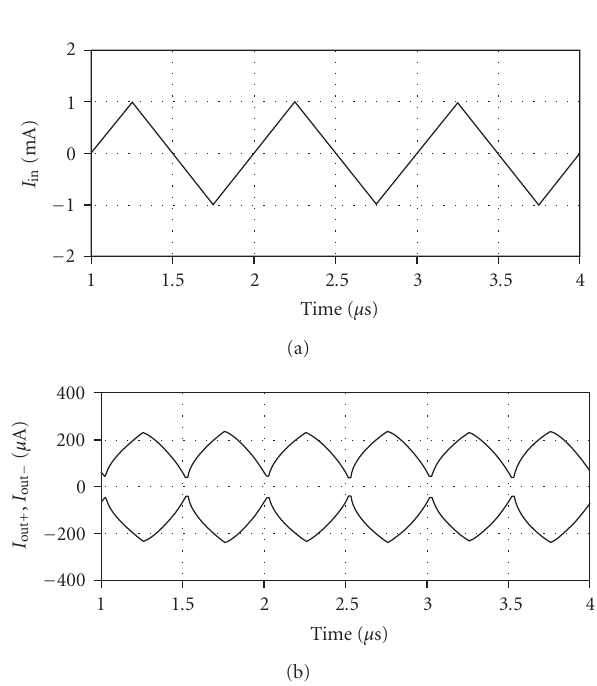
Figure 8: Operation of circuit for the 1 MHz input triangular signal: (a) input waveform; (b) output